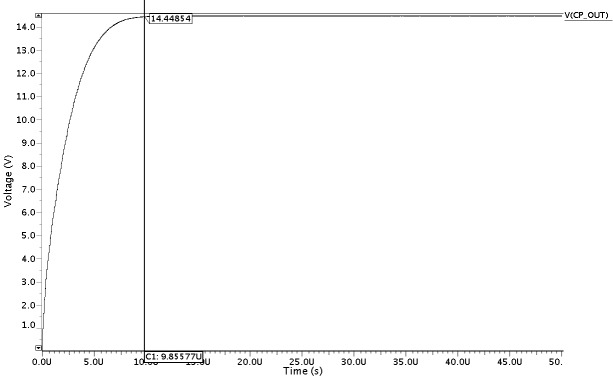
Simulated output ramp-up time for the proposed HVG circuit.